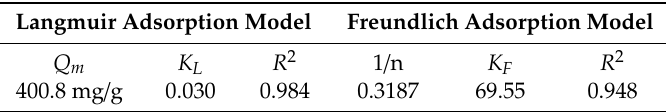
Table 2. Maximum adsorption capacity ( Q m ), Langmuir adsorption constant ( K L ), adsorption